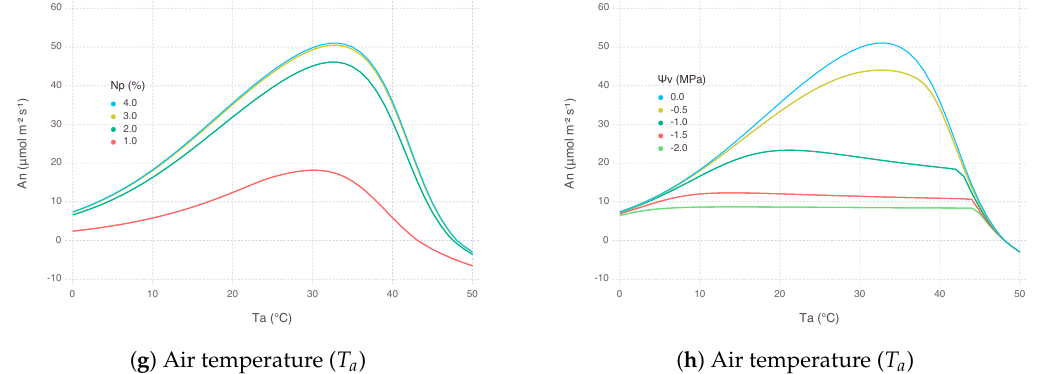
Figure 5. Net photosynthesis rate ( A n ) over a range of environmental input variables at multiple levels of nitrogen or water stress for the two variants of coupled gas-exchange model using Ball–Berry (BB) and Medlyn (MED) stomatal conductance submodels. ( a , c , e , g ) Responses to a varying degree of relative leaf nitrogen content ( N p ) assuming specific leaf area (SLA) was 200cm 2 g − 1 . ( b , d , f , h ) Responses to bulk leaf water potential ( Ψ v